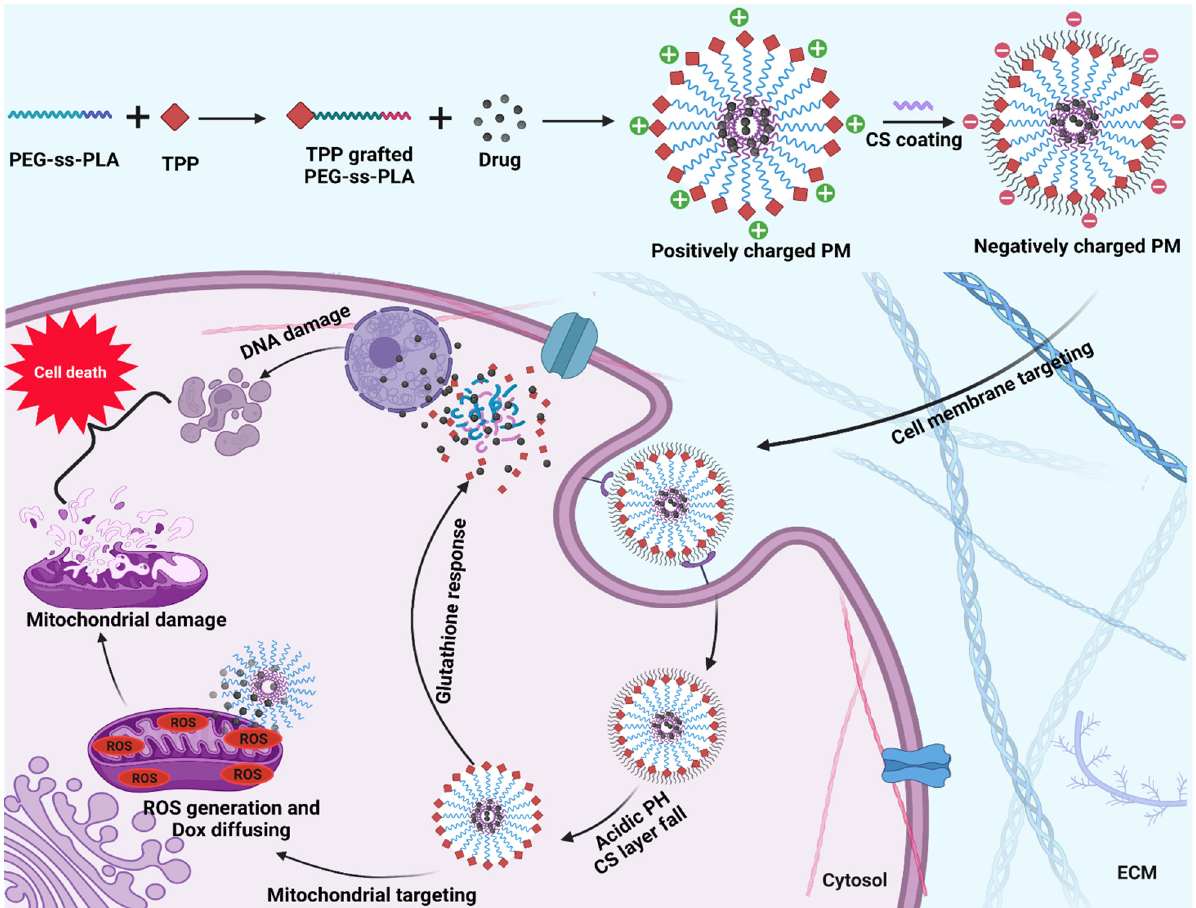
Figure 8. Fabrication of dual targeting and dual-responsive polymeric micelle for mitochondrial